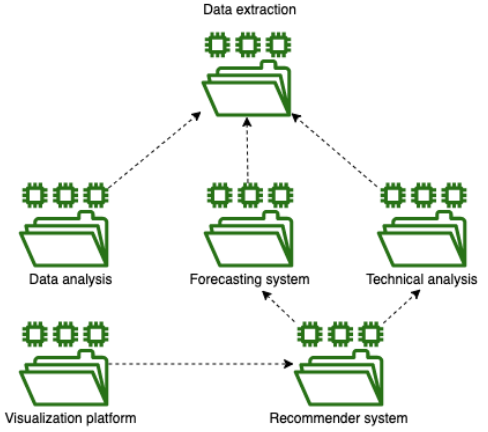
Figure 1. Software system package